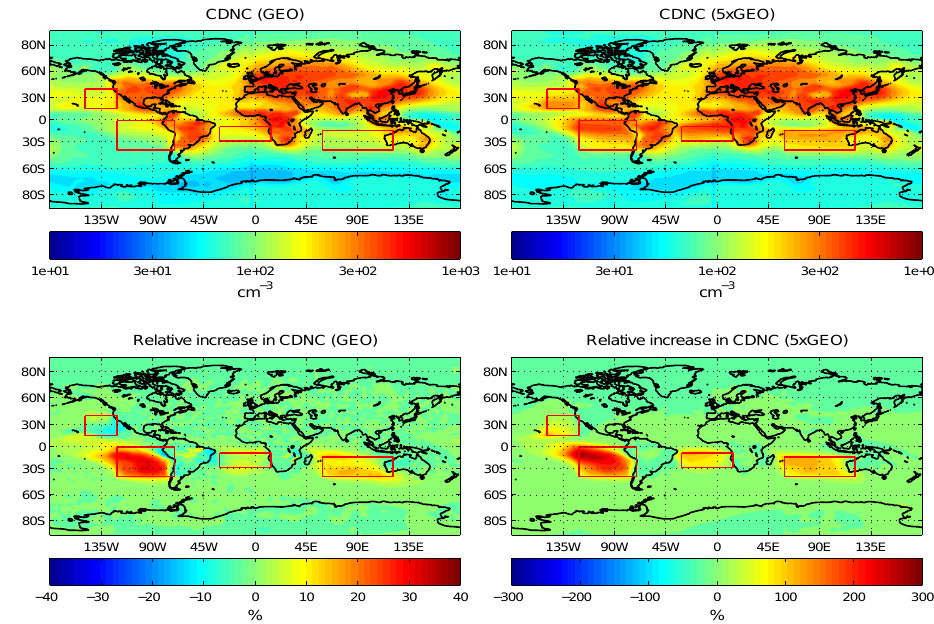
Fig. 2. Annual mean CDNC (top panels) and relative CDNC change (bottom panels) at 1km altitude in GEO and 5 × GEO runs.